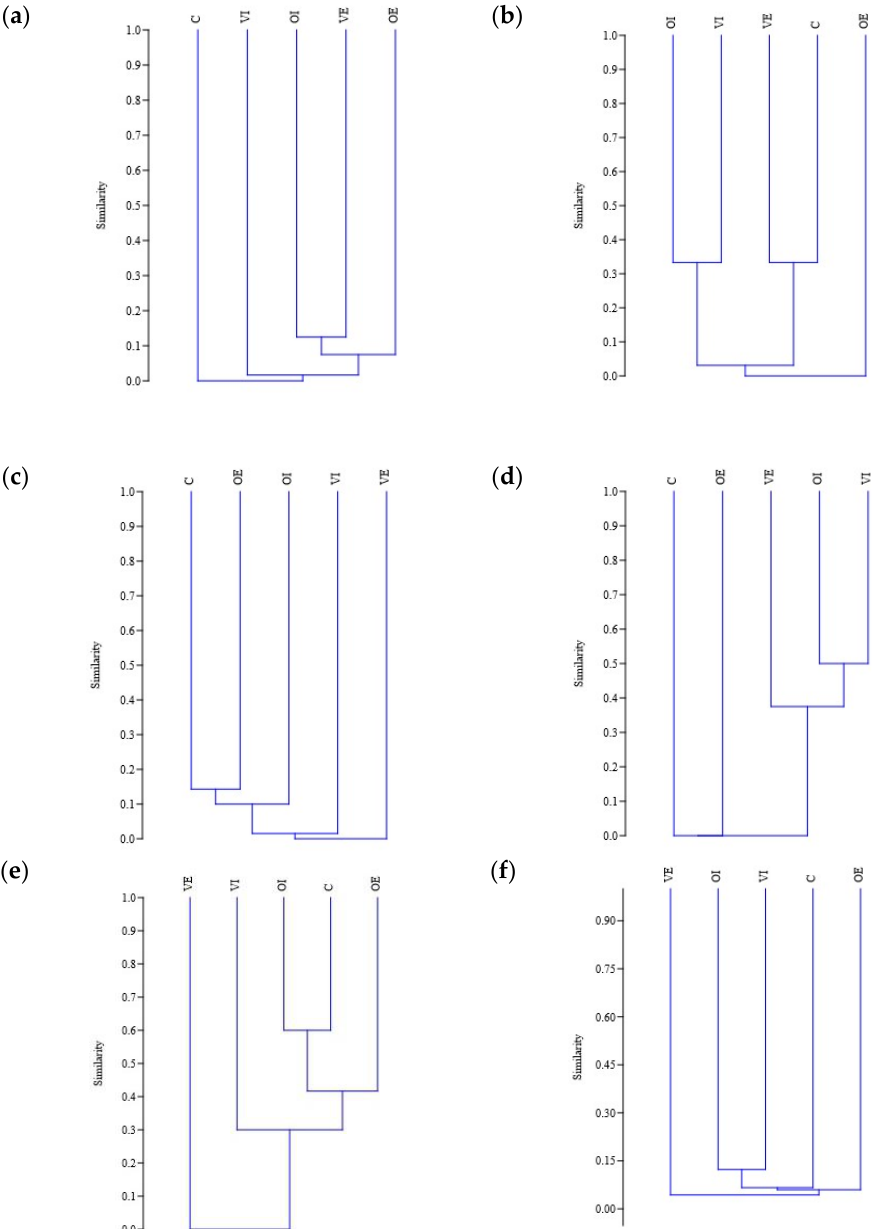
Figure 6. Jaccard similarity between the study sites for Hemipteran ( a ), Hymenopteran ( b ), Dipteran ( c ), Collembolan ( d ), and Isopods ( e ) species, and for all the groups combined ( f ). Study sites are annotated with abbreviations as follows: OE, olive orchard with ecological pest management; OI, olive orchard with integrated pest management; VE, vineyard with ecological pest management; VI, vineyard with integrated pest management, C, natural habitat.